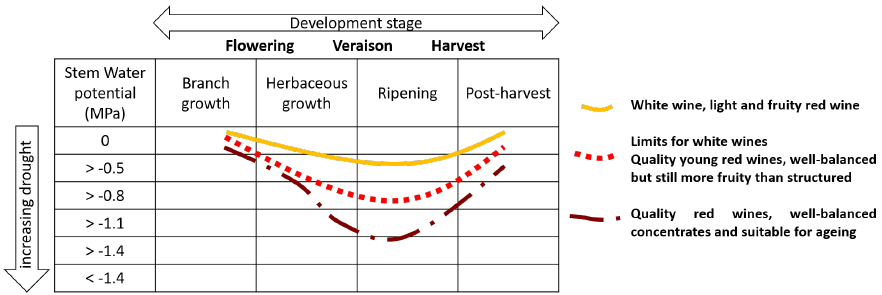
Figure 6. Optimal SWP pathways to produce three distinct wines (adapted from